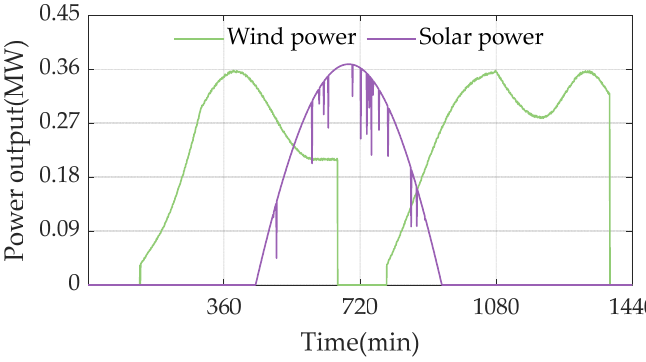
Figure 17. Renewable power output for hydrogen production in Scenario III. The concentration changes of Pipe 1 and Pipe 2 are still the same as in Section 5.4.1.